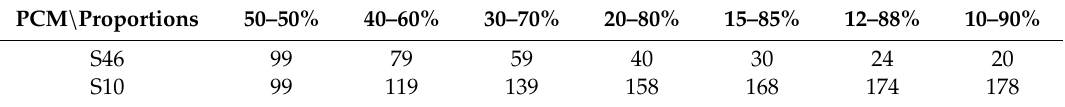
Table 2. The number of containers with the used PCMs as a function of their share in a 2000 L tank. PCM \